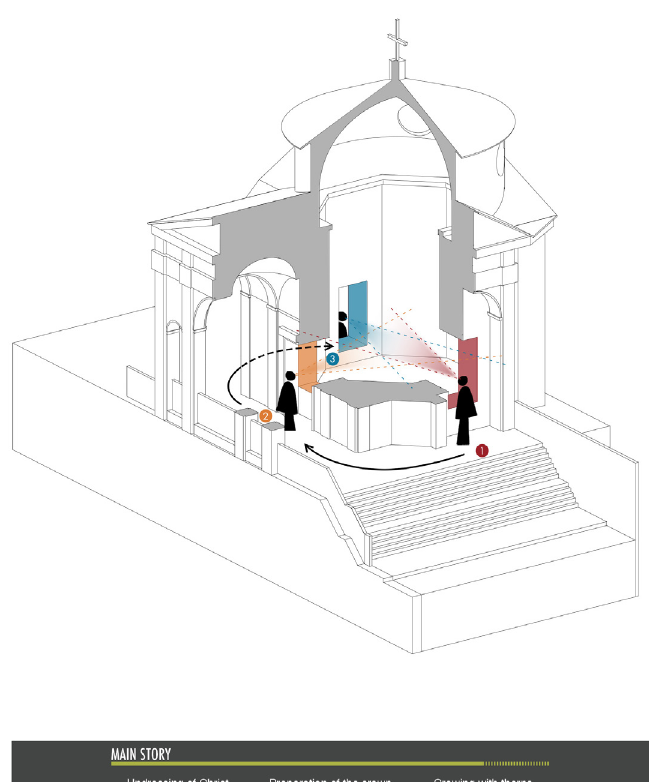
Fig. 11 Preferred points of view’s sequence from which to look at the interior of the chapel, corresponding to the window on the right (1), the central one with the kneeler under the pronaos (2) and the one on the left